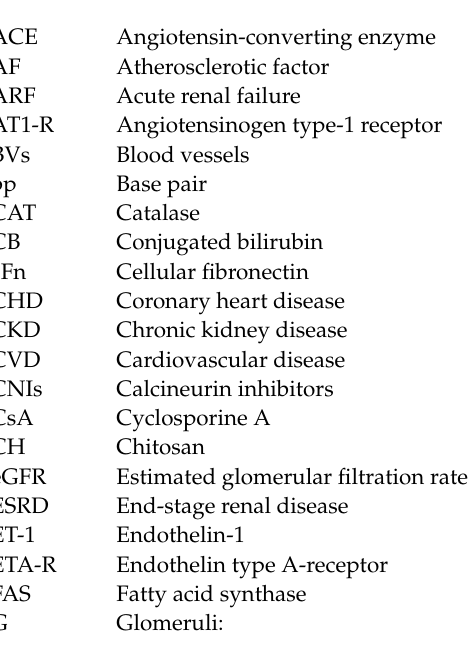
sections; Figure S2: PAS-stained kidney sections; Table S1. Primer sequences used for the target genes and control gene GAPDH in